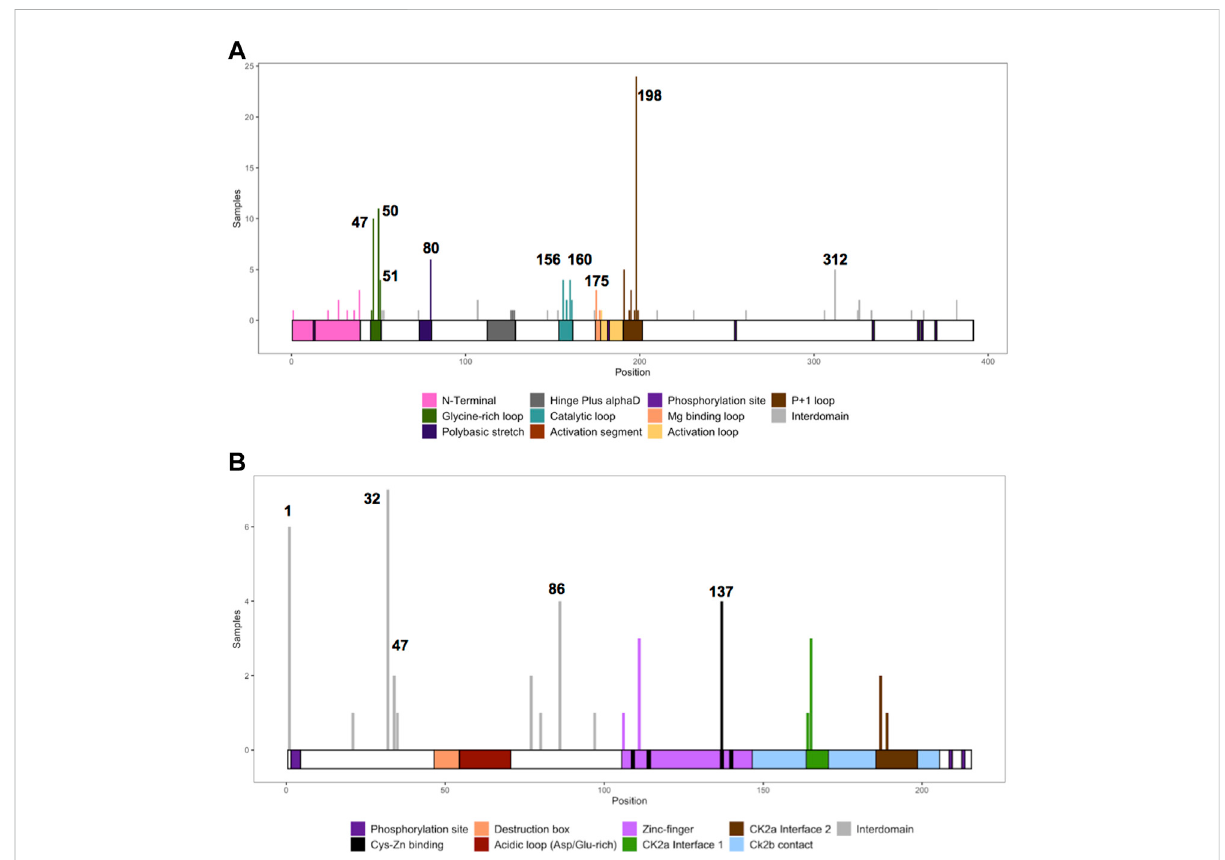
FIGURE 5 HistogramrepresentingthenumberofmissensemutationsalongtheprimarysequenceofCK2 α andCK2 β .TheYaxisrepresentsthenumberof patientswithmissensemutationsineachaminoacidresiduealongtheprimarystructureofCK2 α (A) andCK2 β (B) .TheX-axisrepresentstheprimary sequenceandthefunctionaldomainsofCK2 α (A) andCK2 β (B) .Numbersmarksingleresiduesfoundsigni fi cantinthenon-randommutation cluster (NMC)